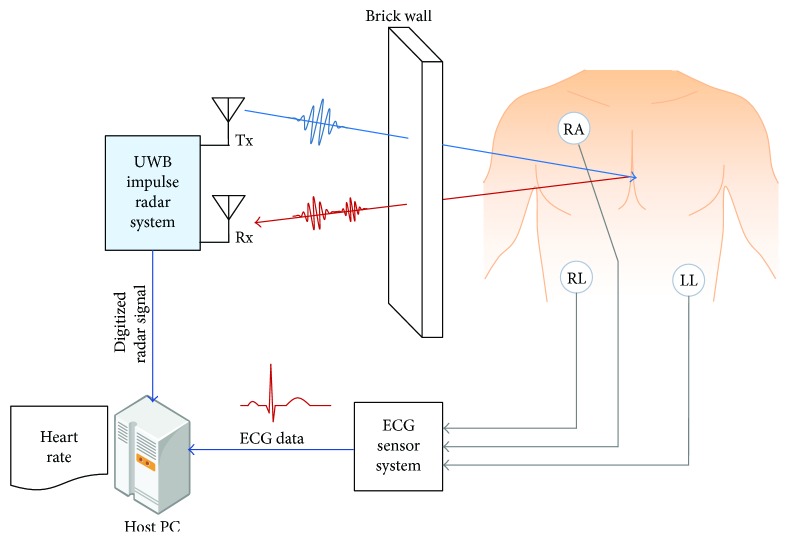
Experimental setup.